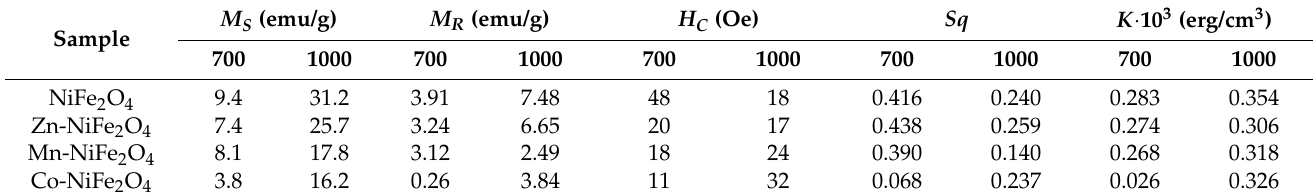
Table 2. Saturation magnetization ( M S ), remanent magnetization ( M R ), coercivity ( H C ), squareness ( S ), and anisotropy ( K ) of virgin and doped NiFe 2 O 4 (Zn-NiFe 2 O 4 , Mn-NiFe 2 O 4 , Co-NiFe 2 O 4 )